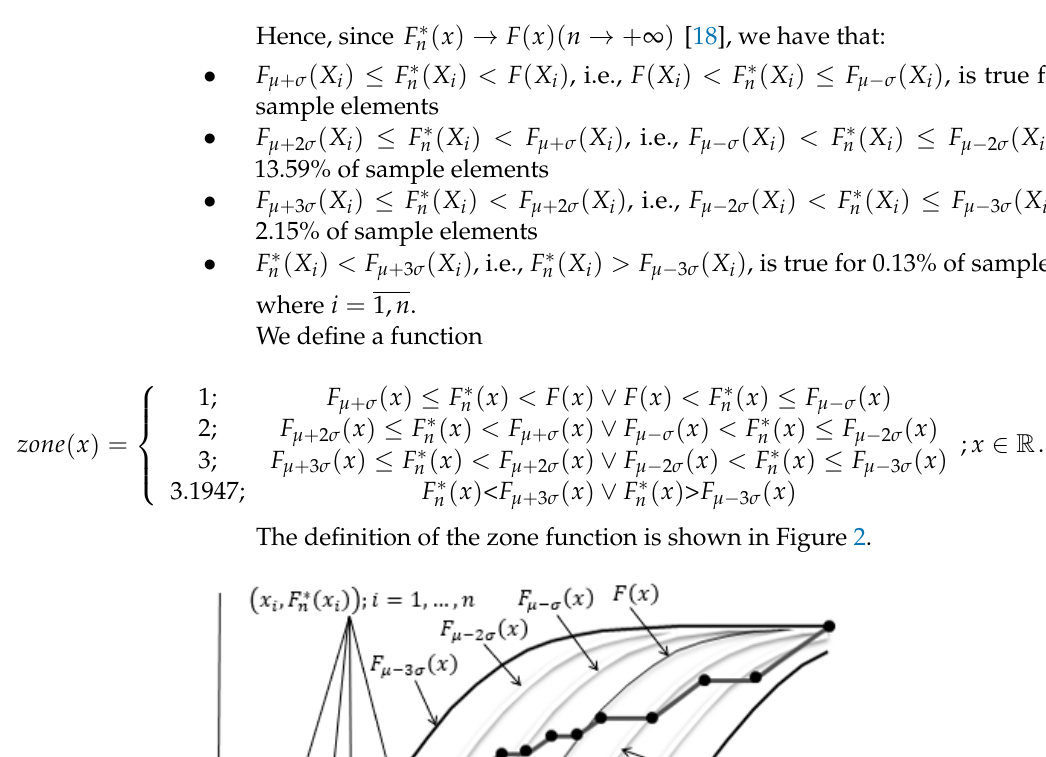
Figure 1. The 3𝜎 rule. Figure 1. The 3 σ rule.